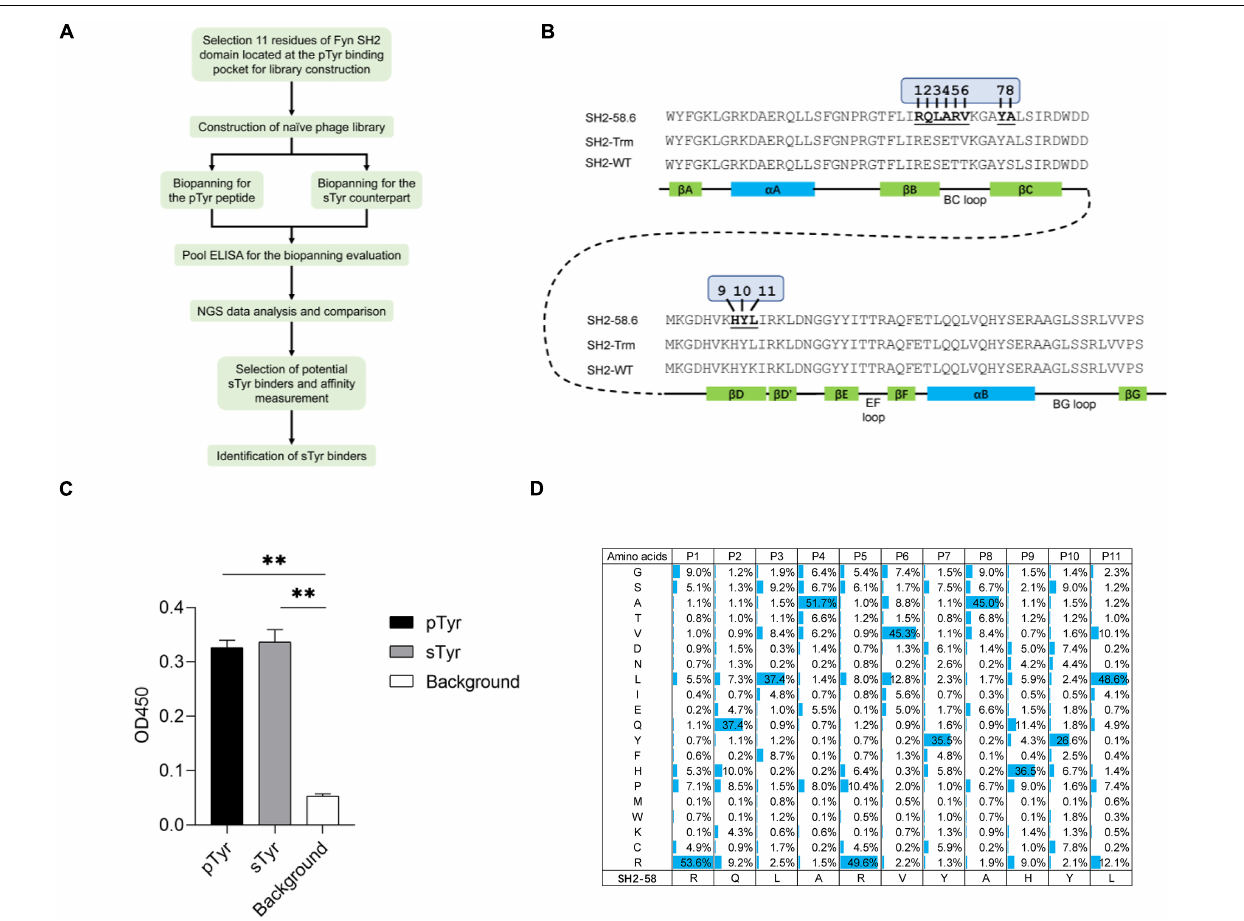
FIGURE 1 | The construction and quality control of a Fyn Src Homology 2 (SH2) domain variant library. (A) A workflow diagram of the selection of the sulfated tyrosine (sTyr) binders. (B) The amino acid sequence and secondary structure of the Fyn SH2 domain (SH2-WT), the SH2 superbinder (SH2-trm) for phosphotyrosine (pTyr) (Kaneko et al., 2012), and the variant SH2-58.6 as the library template in this study (Ju et al., 2016). The 11 evolvable residues were numbered on SH2-58.6. (C) Cross-reactivity of SH2-58.6 binding to pTyr peptide and sTyr counterpart measured by phage enzyme-linked immunosorbent assay (ELISA). Streptavidin precoated in the microplate was taken as the background. Three replicates were performed, and the p -value was performed by Student’s t -test ( ∗∗ p < 0.01). (D) The amino acid distribution at evolvable positions was calculated based on the next-generation sequencing (NGS) data. The corresponding residues of the template SH2-58.6 were shown at the